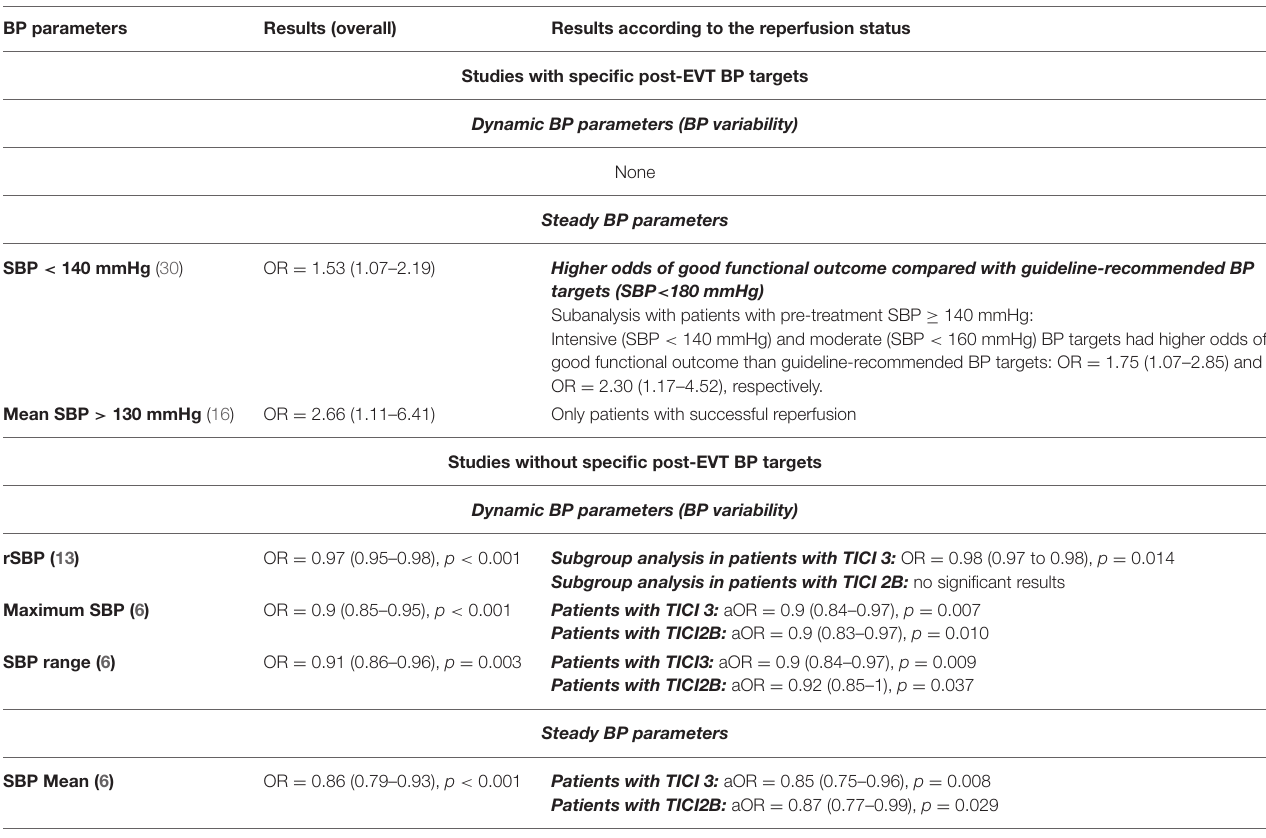
TABLE 2 | BP parameters associated with functional outcome in multivariate analysis, in the overall population and according to the reperfusion status. BP